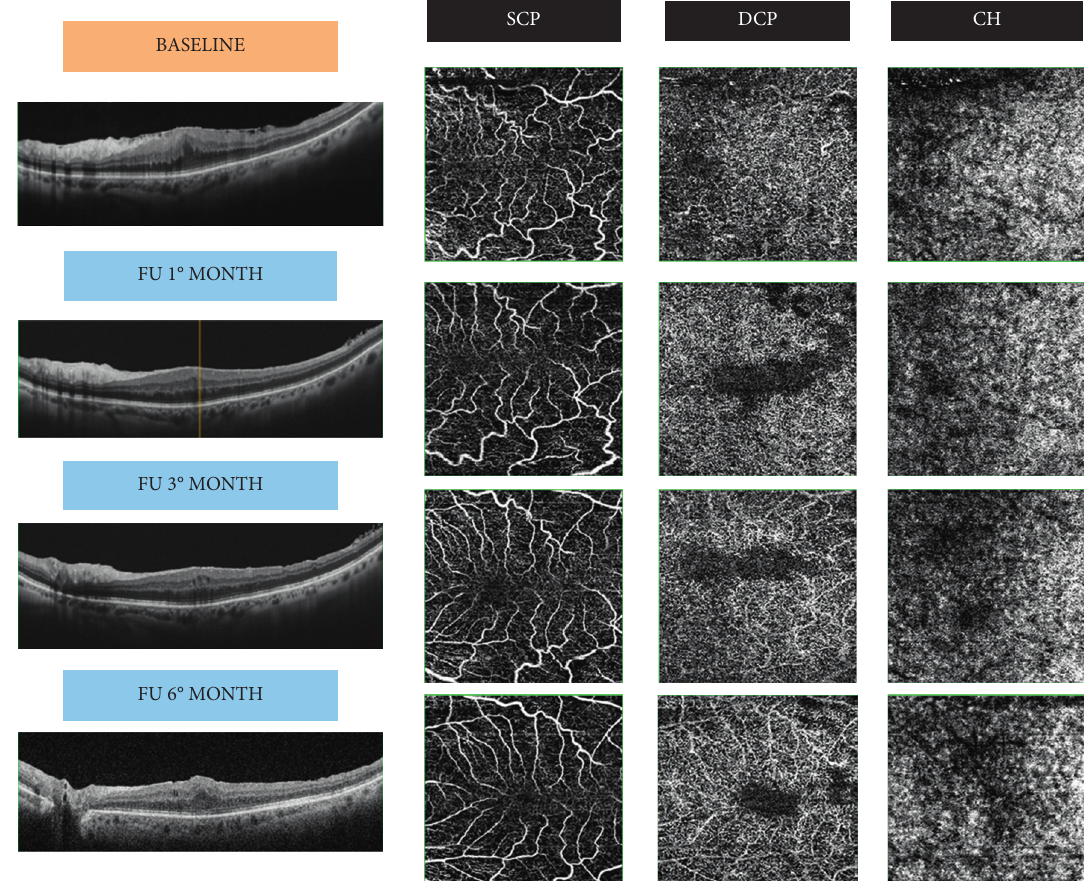
Figure 4: Vascular changes after ERM removal in VD. FU: follow-up; SCP: superficial capillary plexus; DCP: deep capillary plexus; CH: choroid.